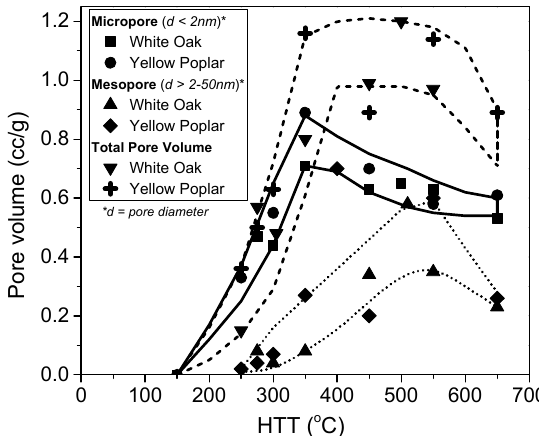
Figure 14. Pore volume of AC from white oak and yellow poplar (H 3 PO 4 /wood= 1.45 g/g, acid strength 28%). Reproduced from [72] with permission from Elsevier © 1998.